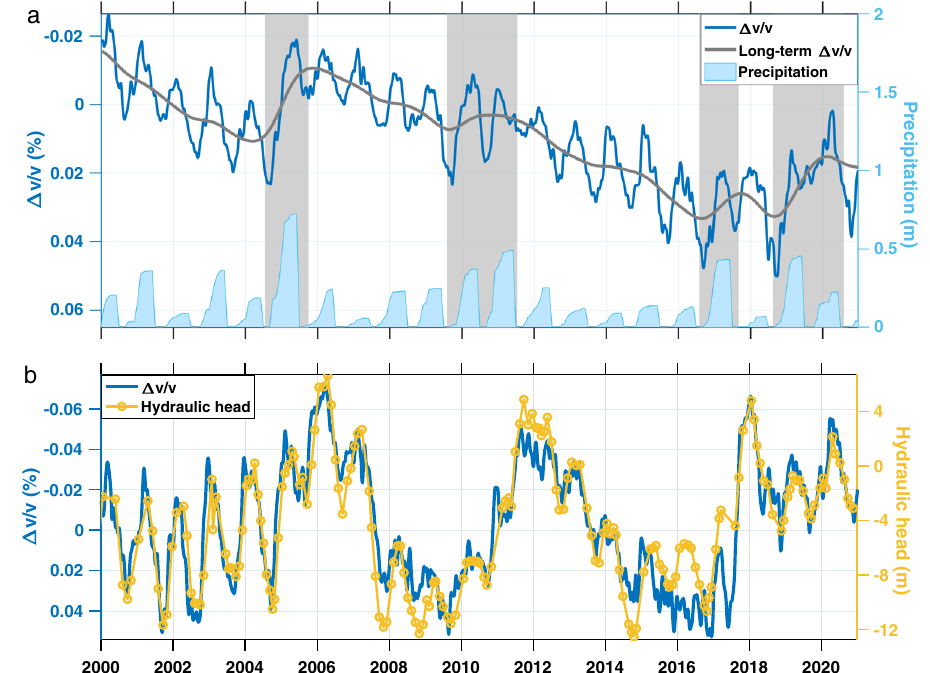
Fig. 2 | Timeseriesof Δ v/v (relative changesinseismic velocity),precipitation, and hydraulic head. a The comparison between Δ v/v (bold blue line) and annual cumulative precipitation (light blue bars). Δ v/v is measured in 0.2 – 2.0Hz and averaged over all spatial grids in the study area. The annual cumulative pre- cipitation is measured at the meteorological station ANA (Fig. 1c). The gray line is